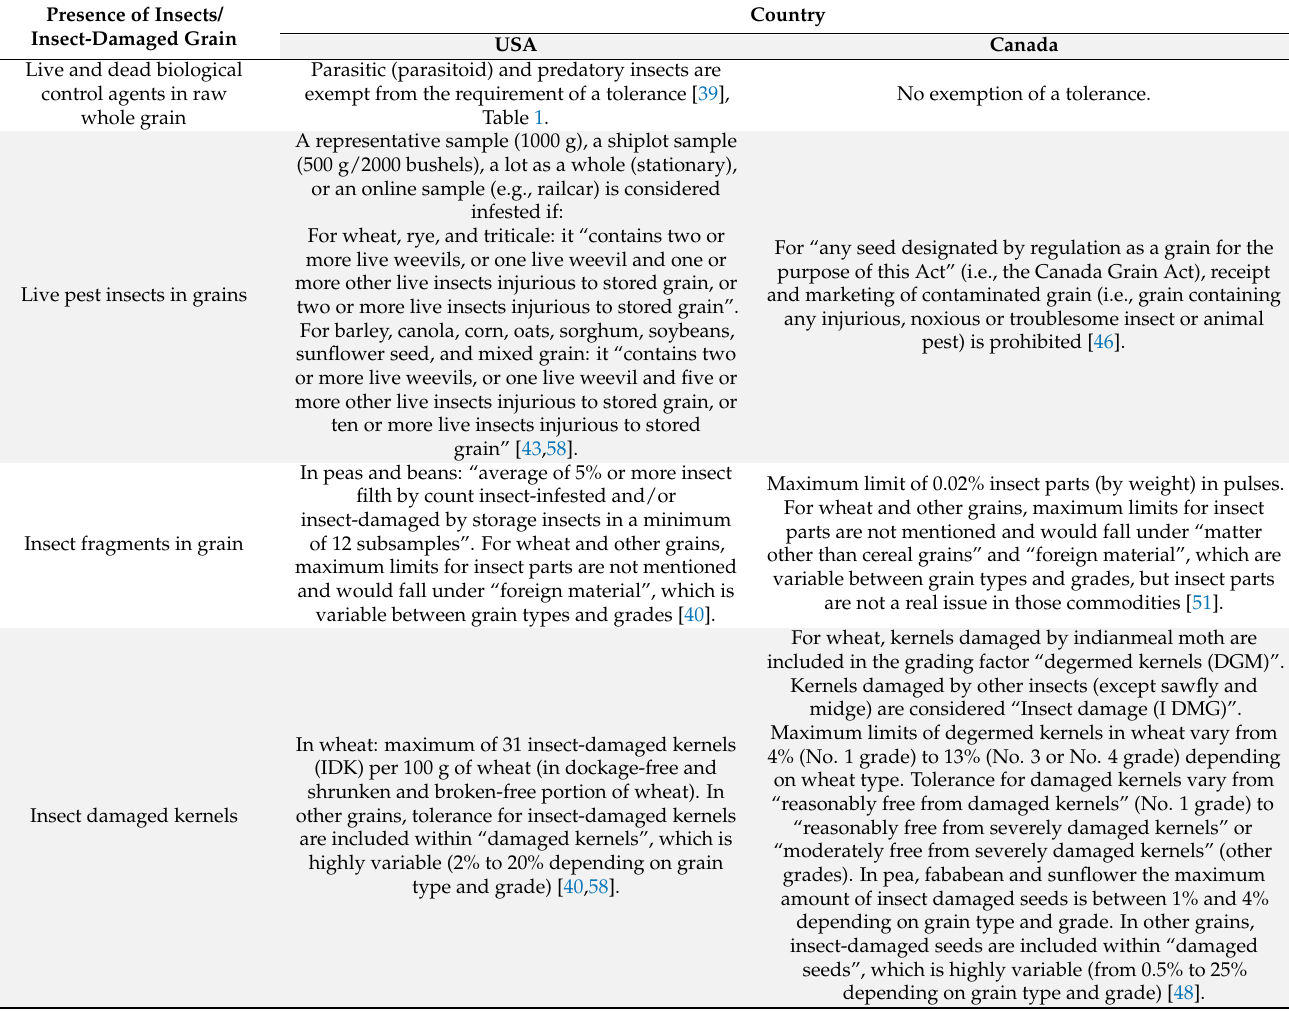
Table 2. Tolerances for live insects in grain, insect fragments/parts in grain and wheat flour, and damaged kernels, in USA and Canada. Presence of Insects/ Insect-Damaged